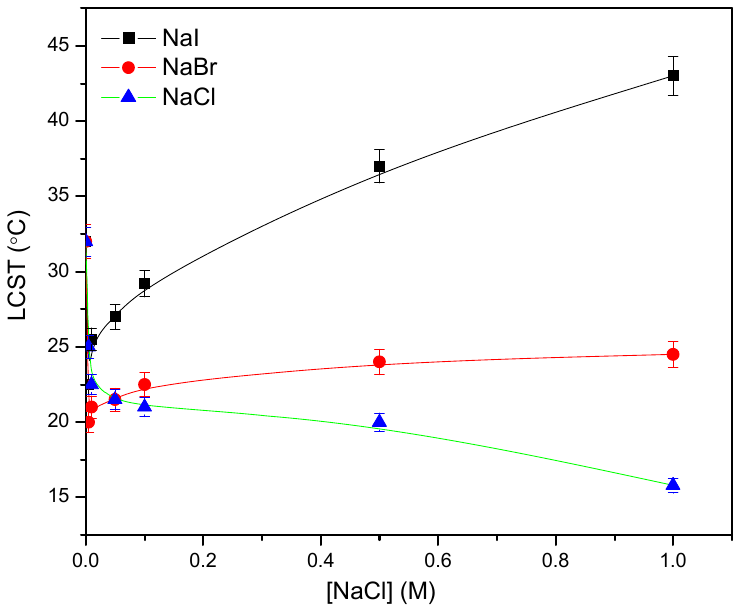
Figure 5. Effect of simple salts on the LCST of copolymer